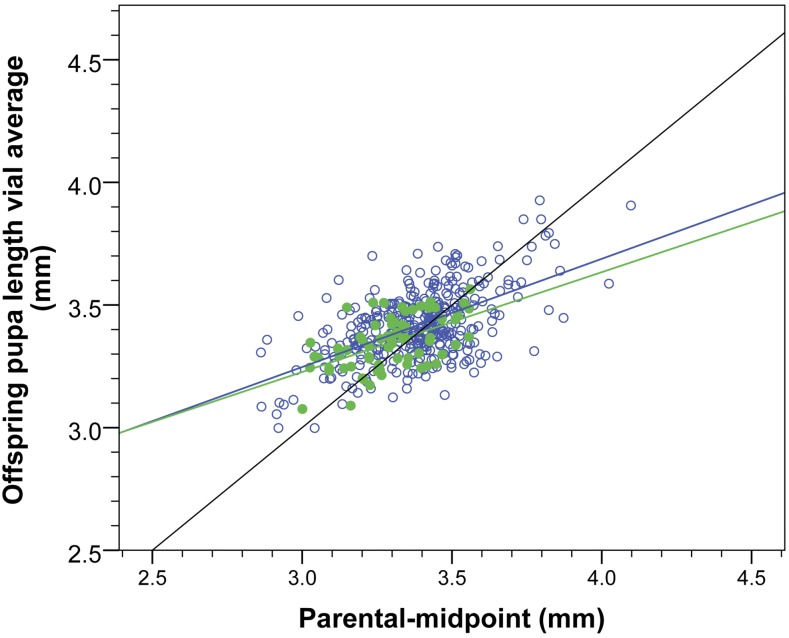
Estimates of mean vial length narrow sense heritability h2 for eight-way and four-way data sets. Despite no overlap in the stocks used to initiate both datasets, there is a remarkable similarity in the slope (h2) and the degree of correlation (R2) among them (see Table 2 for all parameter estimates). Green closed circles, eight-way crosses; blue open circles, four-way crosses.